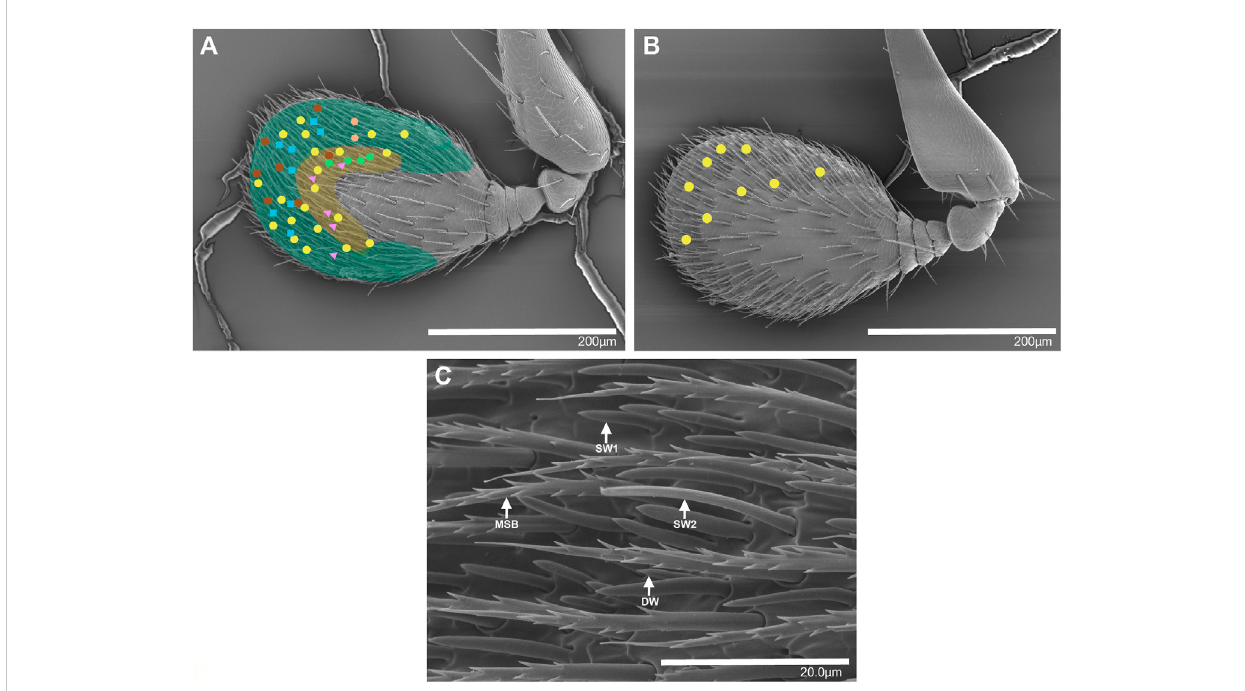
FIGURE 1 Scanning electron micrographs of the antennal club of female T. lineatum showing the approximate positions of six OSN classes, the antennal regions with different densities of sensilla, and different types of sensilla. (A) The ventral view of the terminal segment forming the antennal club. The yellow coloured area is densely covered by sensilla while the green coloured area has a lower density of sensilla. Yellow circles: lineatin OSNs (OSN class 1), blue squares: 2-methyl-3-buten-2-ol OSNs (OSN class 3), green hexagons: 2-methyl-1-butanol OSNs (OSN class 4), orange hexagons: 3- methyl-1-butanolOSNs(OSNclass5),pinktriangles:ethylacetateOSNs(OSNclass6),browncircles:(±)-1-octen-3-ol(OSNclass12). (B) Thedorsalview of the terminal segment forming the antennal club, with additional lineatin-responsive OSNs mapped (yellow circles). (C) Ventral side of antennal club showing a magni fi ed view of putative double walled sensilla (DW), putative single walled sensilla 1 (SW1), putative single walled sensilla 2 (SW2), and mechanosensory bristles